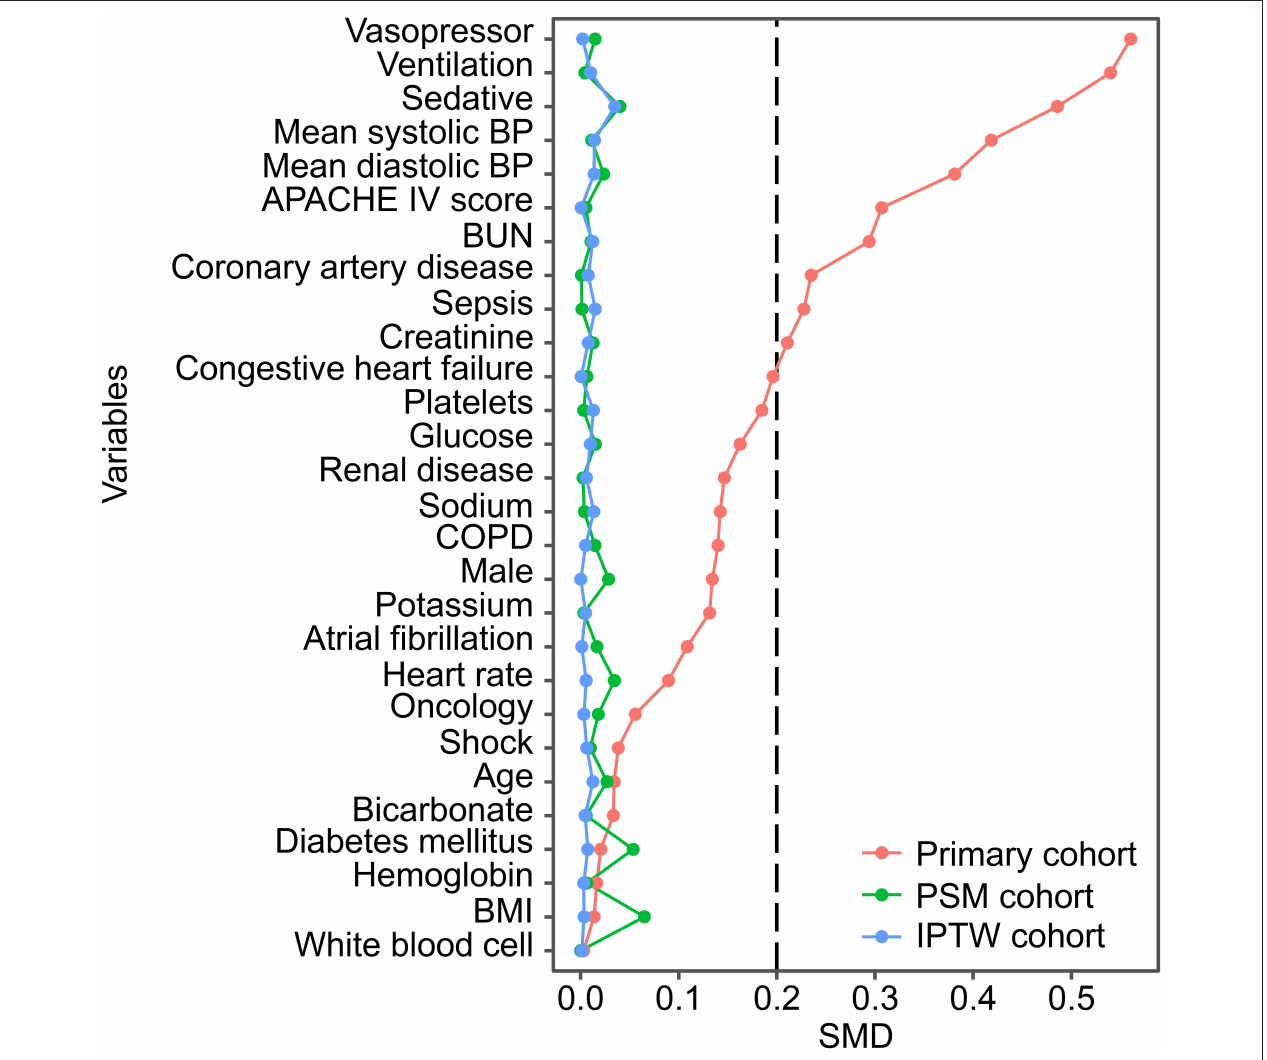
FIGURE 2 | SMD between the no IBP and IBP groups in each cohort. Variables were ranked by the SMD. BP, blood pressure; APACHE, Acute Physiology and Chronic Health Evaluation; BUN, blood urea nitrogen; COPD, chronic obstructive pulmonary disease; BMI, body mass index; PSM, propensity-score matched; IPTW, inverse probability of treatment weighting; SMD, standardized mean